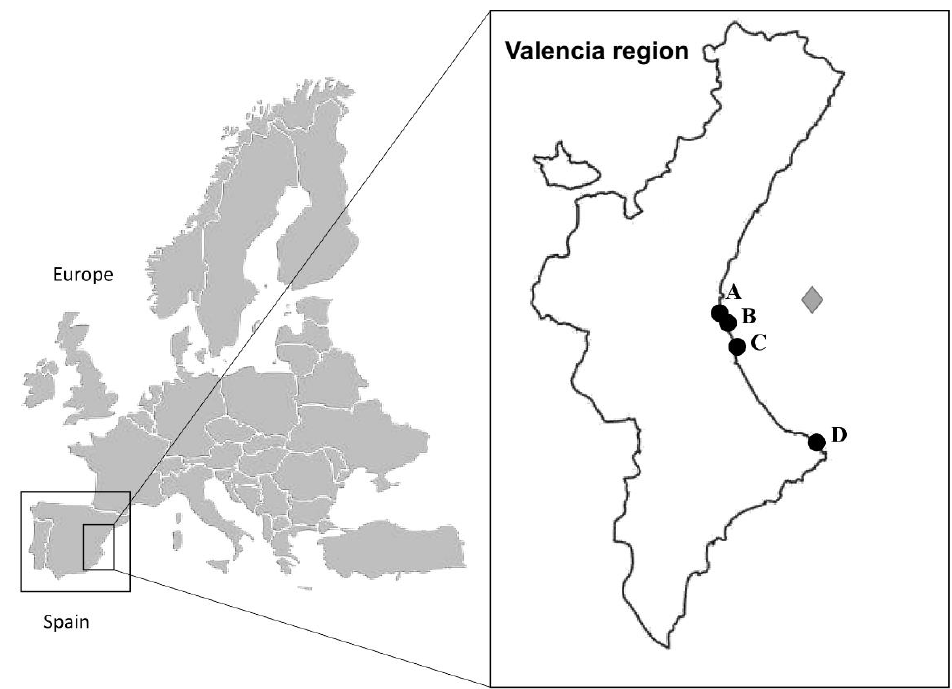
Figure 1. Geographical locations of aquarium and fisheries for the small-spotted catshark ( Scyliorhi- nus canicula ) used in this study. Maps of Europe, Spain, and Valencia (area inside the square). Black dots indicate the sample collection points. (A) Oceanogràfic de Valencia (aquarium-housed ani- mals); (B,C,D) Valencia ( 39°26′45″ N , 0°19′12″ W), Cullera (39° 09′58″ N, 0° 15′10″ W), and Jávea Ports ( 38°47′21″ N 0°09′47″ E ), respectively (wild-captured animals during fishing). The gray diamond indicates the Valencia buoy, (39° 52′ N, 0° 20′ E) used to monitor water parameters related to wild- captured animals (www.puertos.es/es-es/oceanografia/Paginas/portus.aspx, accessed 12 th of April, 2020).